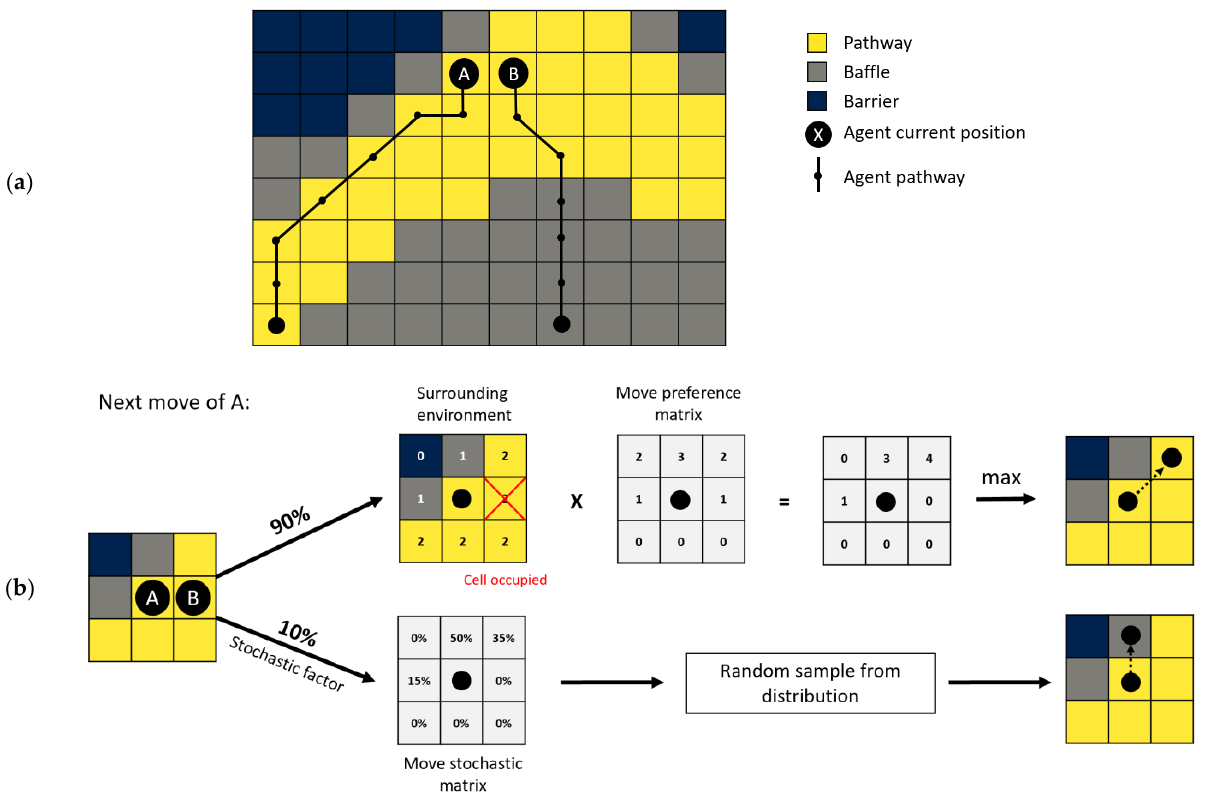
Figure 1. ( a ) Migration of two agents moving in a 2D environment; ( b ) decision-making process for selecting the next move of agent A. selecting the next move of agent